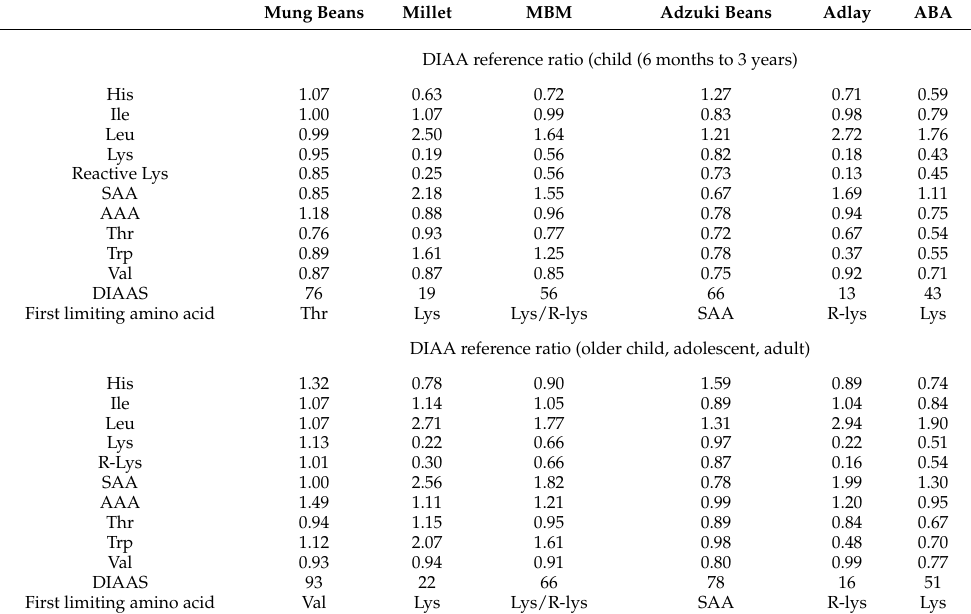
Table 3. Digestible indispensable amino acid scores (DIAAS) for the cooked pulses, cereals and pulse/cereal